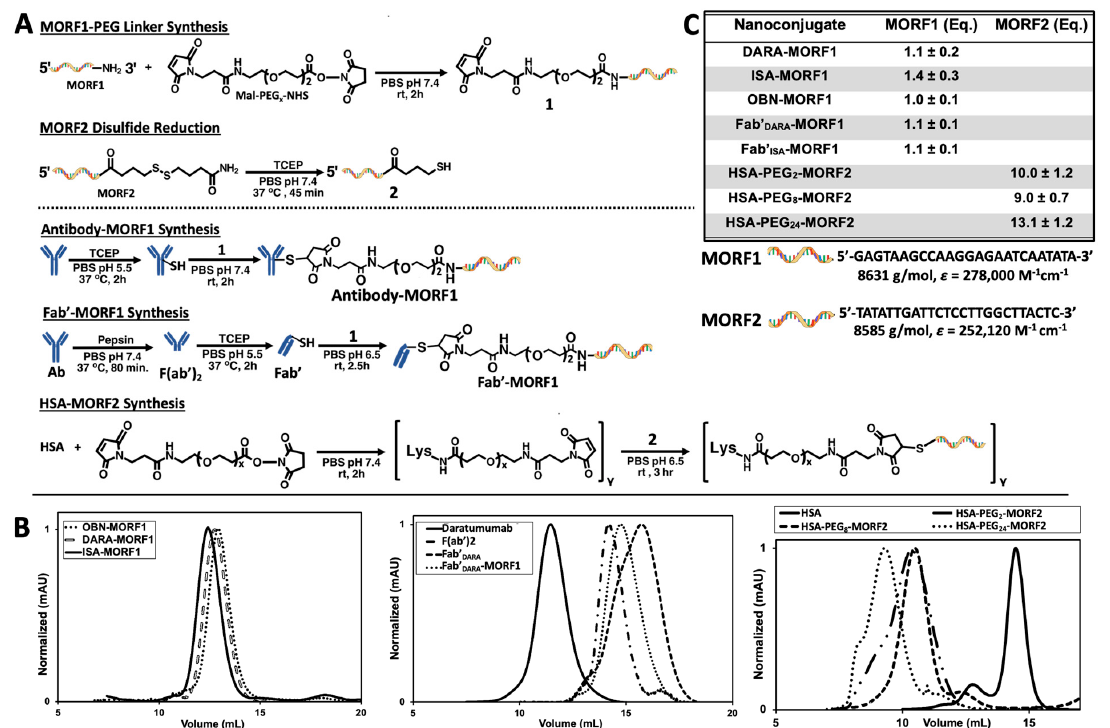
Figure 1. Nanoconjugate synthesis and characterization. ( A ) Synthetic route to produce antibody-MORF1, Fab’-MORF1 and HSA-(MORF2) y conjugates. Note: If not otherwise stated all conjugates contain a diethyleneglycol unit in the spacer inserted by SM-PEG2. Conjugates containing longer spacers are denoted as, e.g., Fab’-PEG 8 -MORF1. ( B ) Nanoconjugate size exclusion chromatography profiles detected on a Superdex 200 10/300 GL column, PBS (pH 7.4) as eluant at 0.4 mL/min flow rate. ( C ) Characterization (MORF valence) of nanoconjugates determined using UV-Vis absorbance at λ = 260 nm and BCA assay.